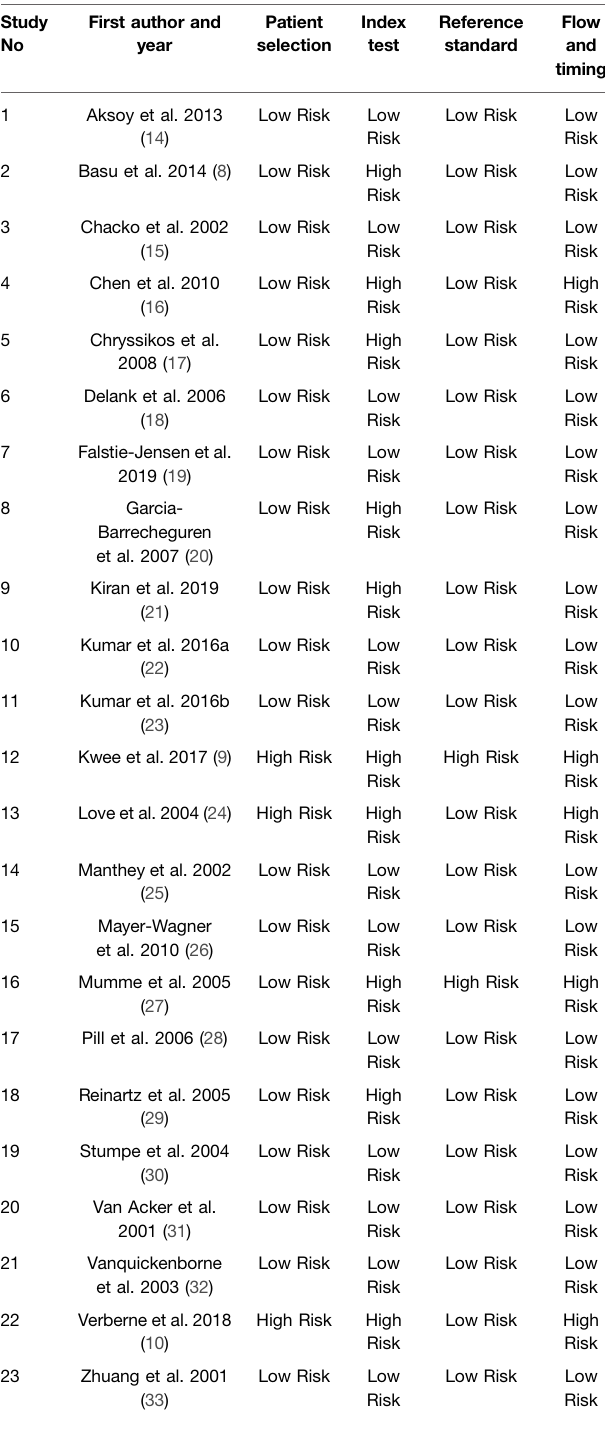
TABLE 2 | Quality assessment of the included studies ( N